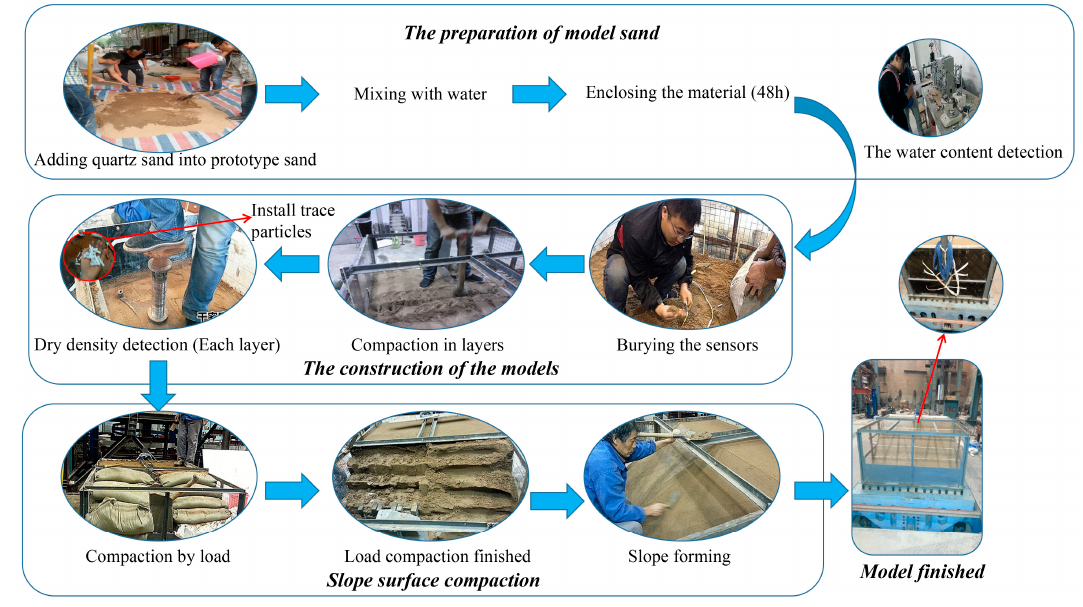
Figure 5. Construction process of the models.